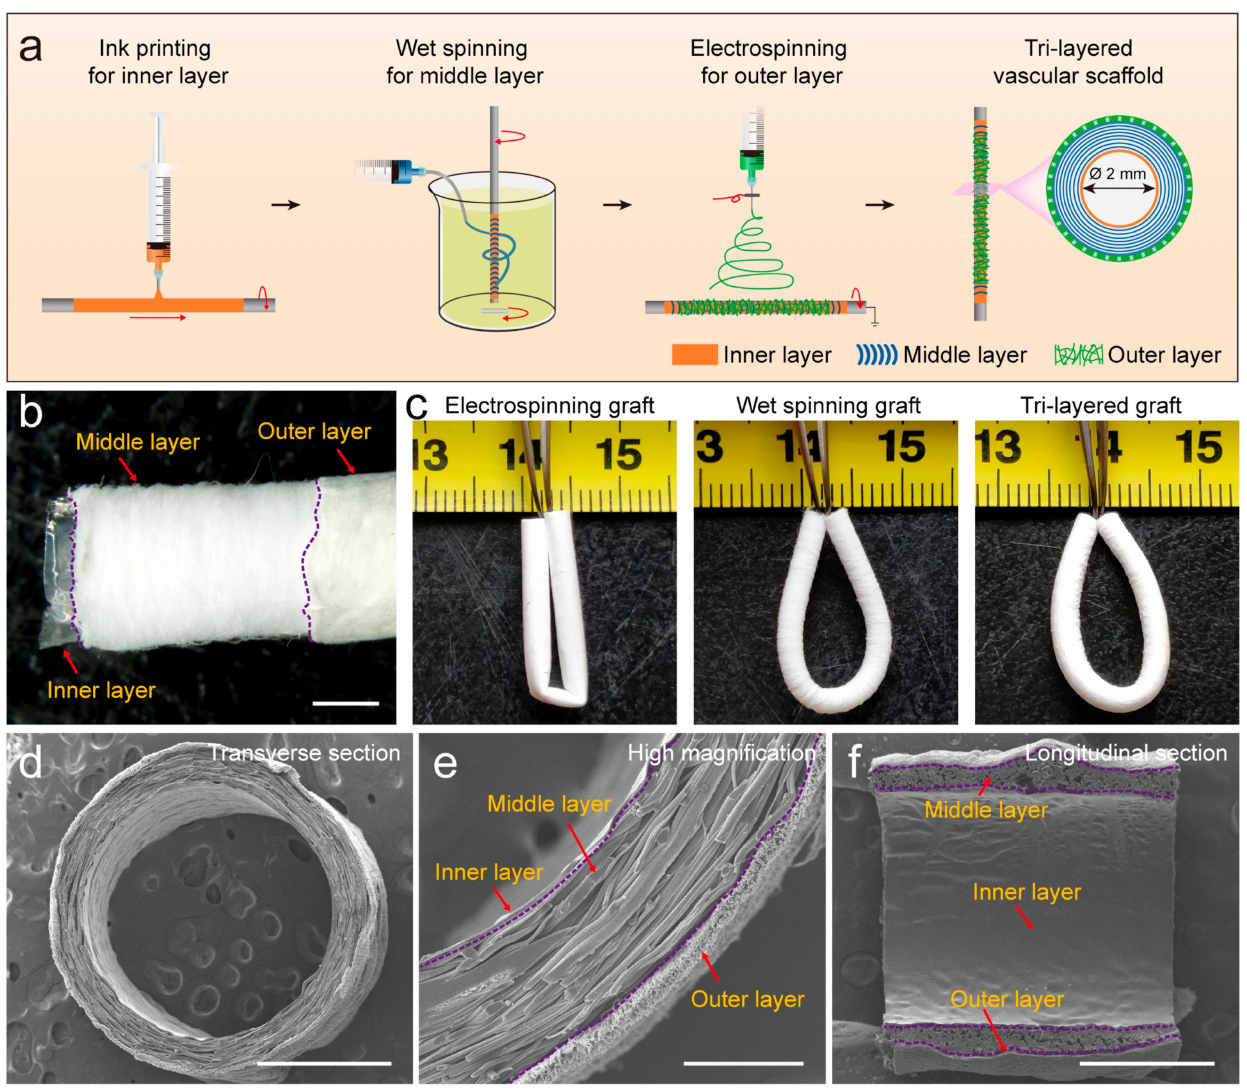
Figure 1. Fabrication and structure of TVGs. ( a ) Schematic illustration showing the prepara- tion process. ( b ) Gross morphology and ( c ) kink resistance. ( d – f ) SEM images representing the macro-/micro-structure in the cross and longitudinal section. Scale bars: ( b , d ), 1 mm; ( e ) 200 µ m; ( f ) 1